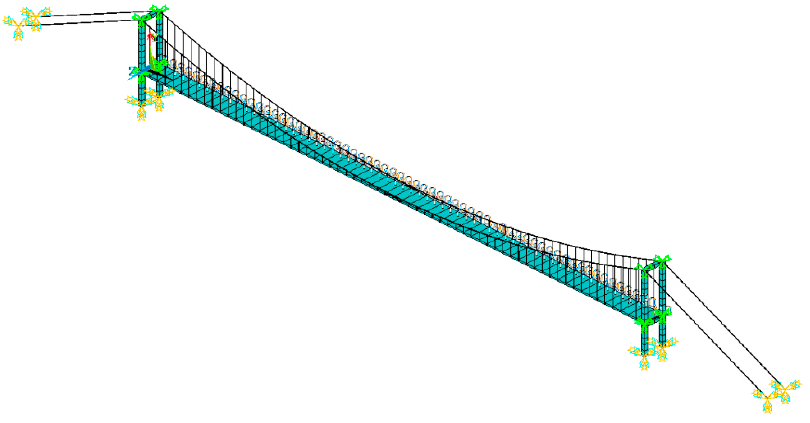
Figure 10. Stochastic load model for dense traffic flow.